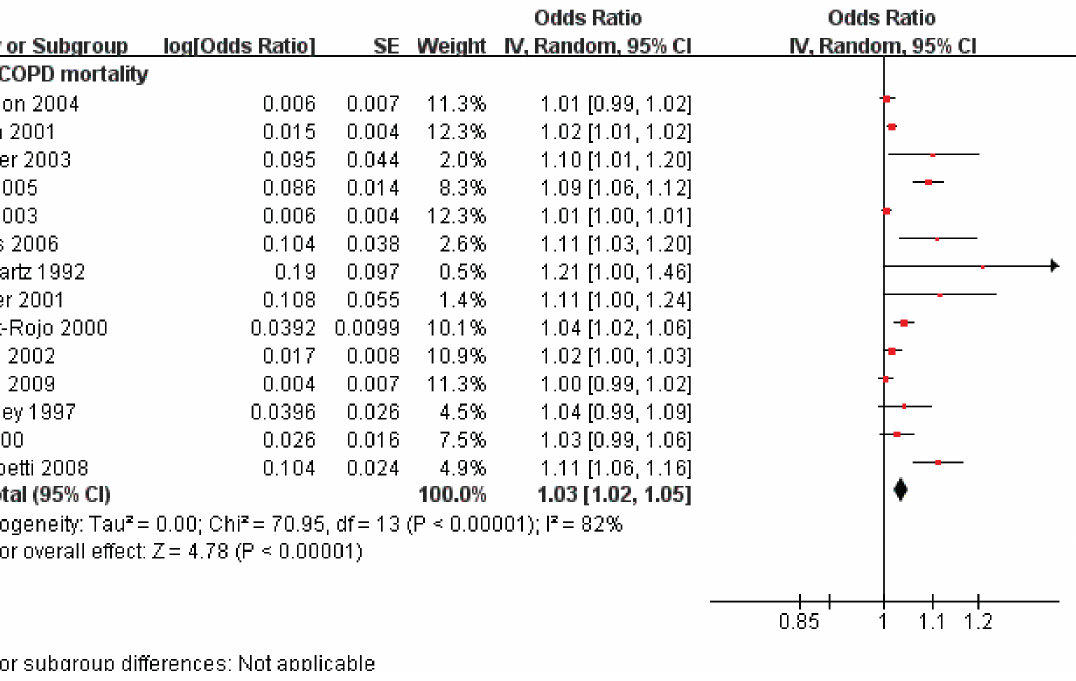
Table 1. Subgroup analysis for the contribution of outdoor air pollution to COPD mortality *